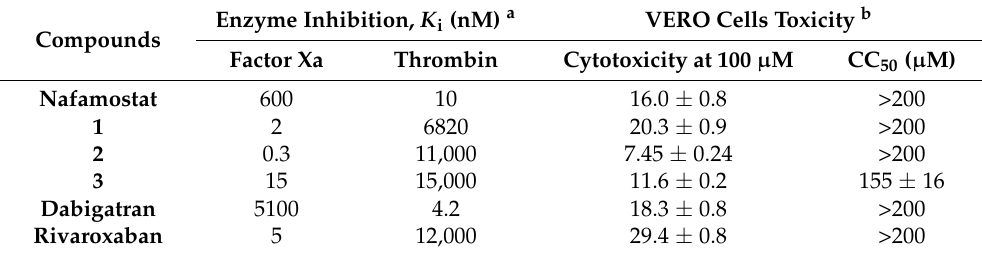
Table 1. In vitro affinities ( K i values) to thrombin and factor Xa, and cytotoxicity data (Vero E6 cell line). Enzyme Inhibition, K i (nM) Compounds